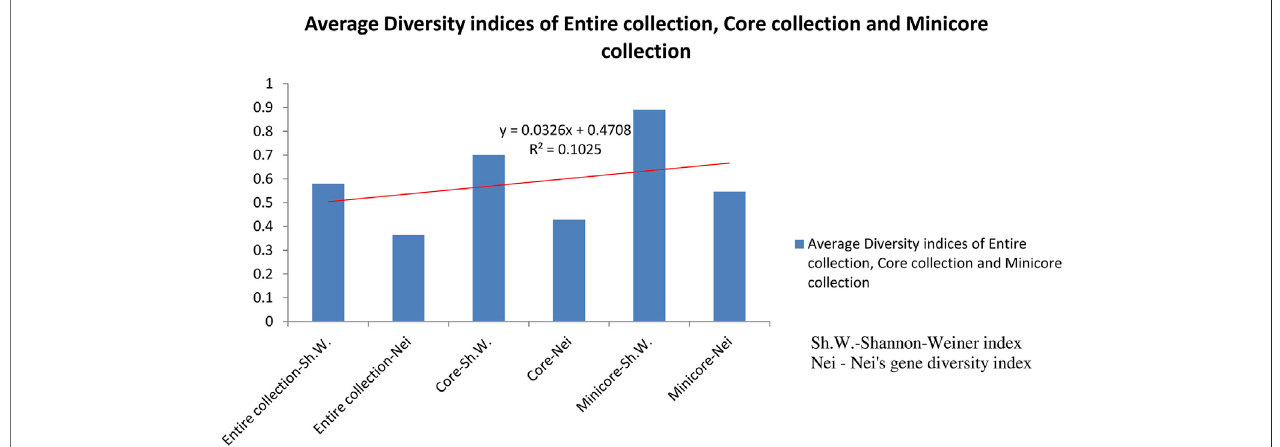
FIGURE 4 | Graph showing average diversity indices of entire collection, core collection, and mini core